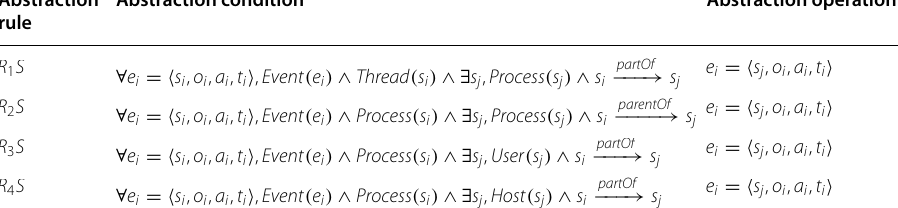
Table 6 Abstraction rules of subjects Abstraction rule